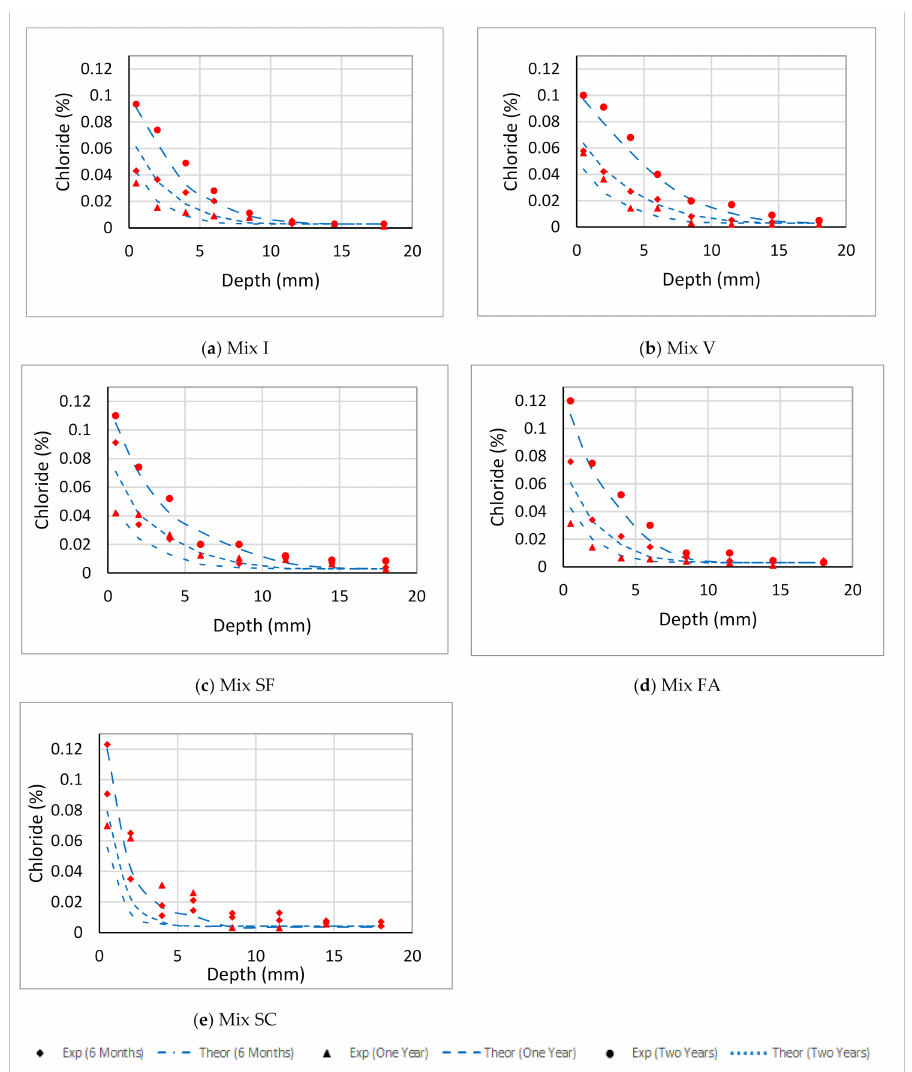
Figure 5. Chloride profiles for mixes in the coastal zone using the experimental binding results. ( a ) concrete with 100% ordinary Portland cement (OPC), ( b ) concrete with 100% type V cement (Sulfate resistance), ( c ) concrete with 6% silica fumes and 94% OPC, ( d ) concrete with 25% fly ash and 75% OPC, ( e ) concrete with 70% slag cement and 30%